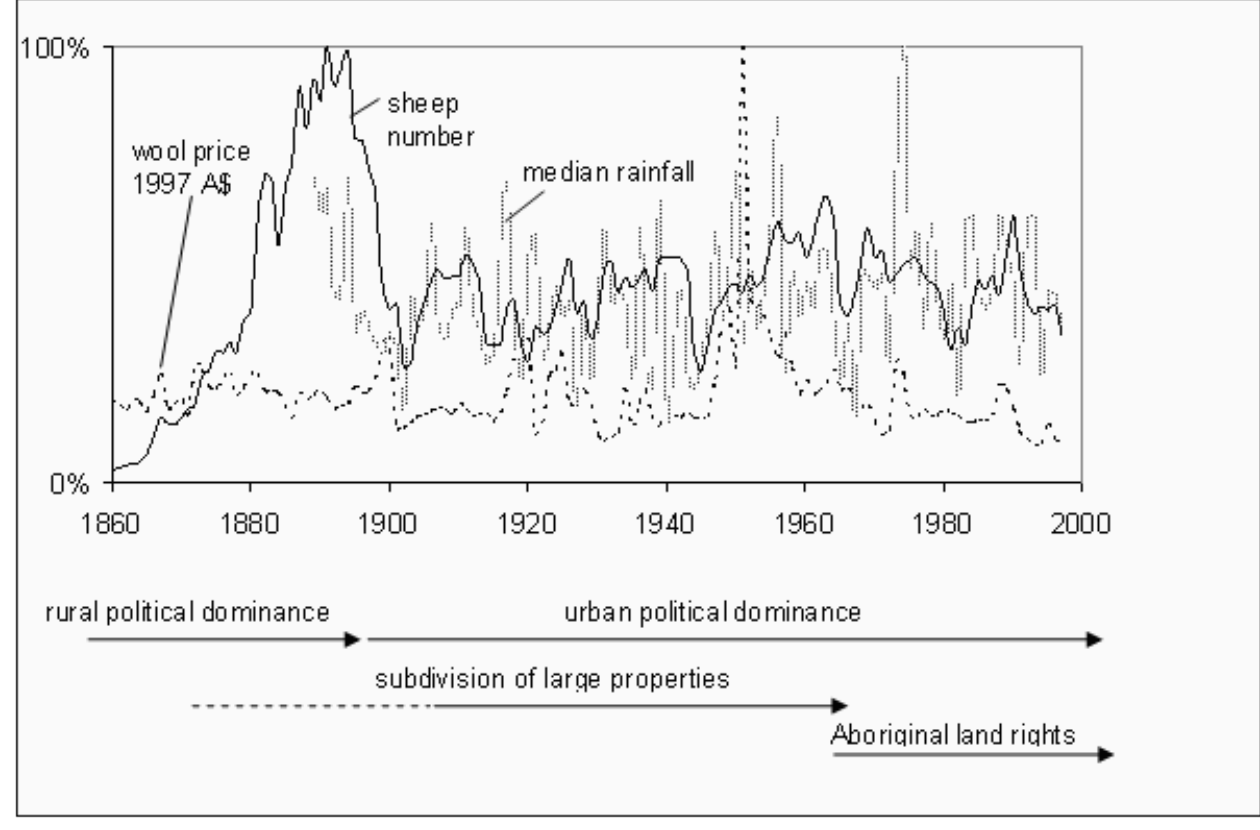
Fig. 5 . Rainfall, number of sheep, wool price, and policy changes in New South Wales, Australia. Sheep numbers for 1860–1902 are from Barnard (1962); for 1903–1979, from the Western Lands Commissioner (1979); for 1980–200, from the ASPIRE database produced by the Australian Bureau of Agricultural and Resource